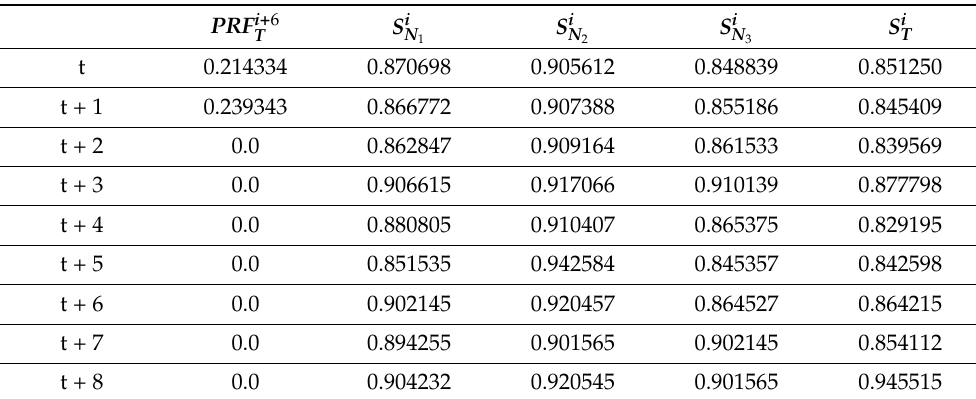
Table 1. Example prediction dataset.